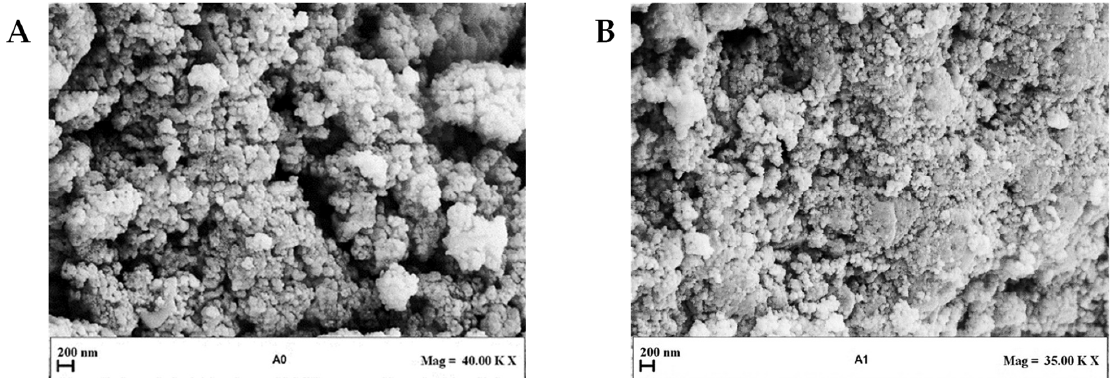
Figure 3. Representative FESEM images of liposomes produced at different Ab/Lipids and at a fixed WFR of 1 mL/min: ( A ) Sample with Ab/Lipids equal to 0% ( w / w ) and ( B ) Sample with Ab/Lipids equal to 0.625% ( w / w ). FESEM: field emission scanning electron microscope, Ab/Lipids: antibody ‐ to ‐ lipid mass ratio, WFR: water flow rate.